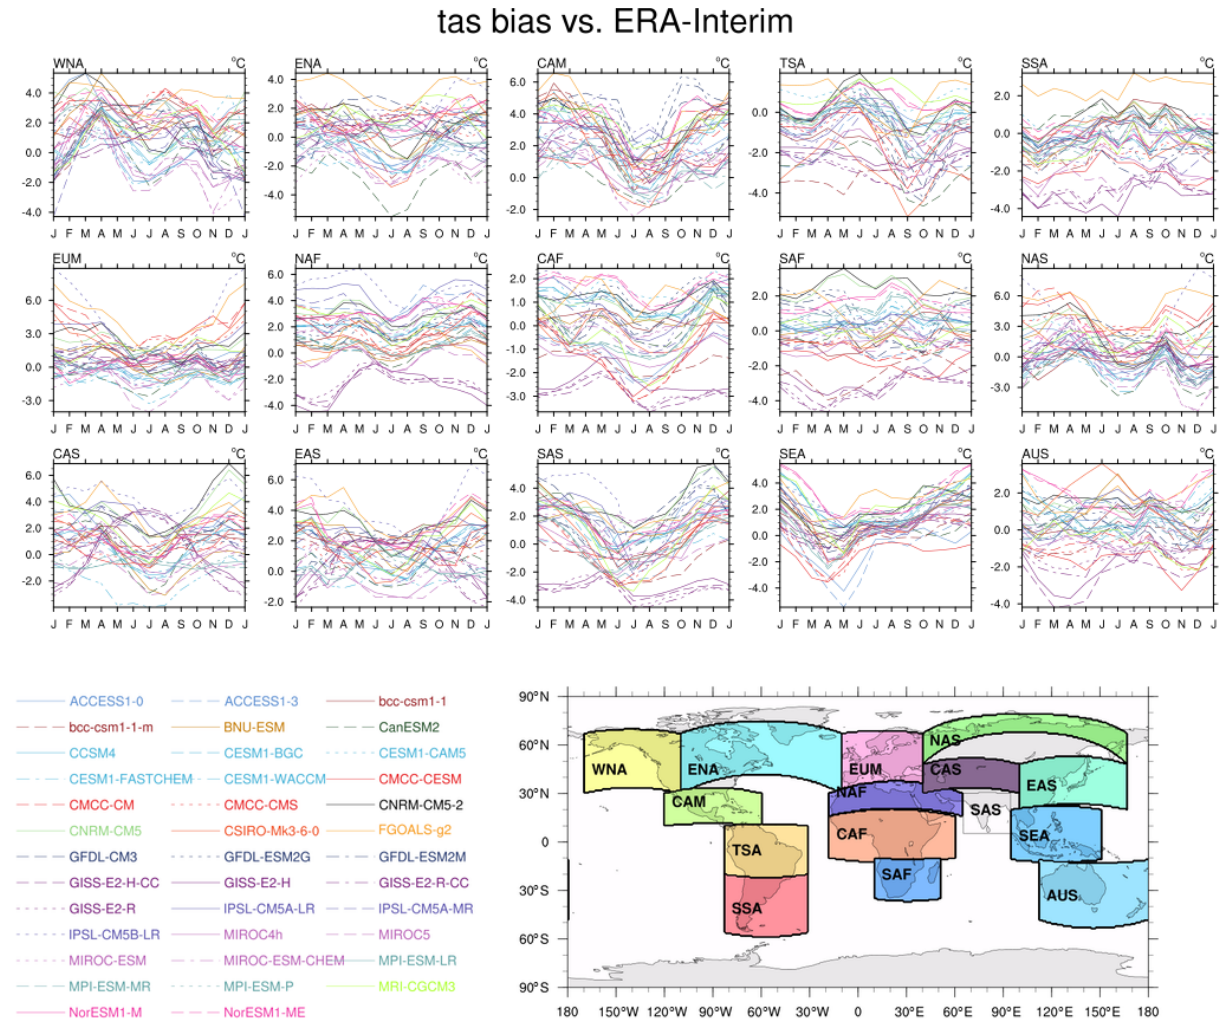
Figure 13. Difference of the mean seasonal cycle for the surface temperature (tas) between 38 CMIP5 models and ERA-Interim data averaged for 1980–1999 over land in different regions: western North America (WNA), eastern North America (ENA), Central America (CAM), tropical South America (TSA), southern South America (SSA), Europe and the Mediterranean (EUM), North Africa (NAF), central Africa (CAF), southern Africa (SAF), northern Asia (NAS), central Asia (CAS), East Asia (EAS), South Asia (SAS), Southeast Asia (SEA), and Australia (AUS). Similar to Fig. 9.38a of the IPCC AR5 report (Flato et al., 2013) and produced with recipe_flato13ipcc.yml ; for details see Sect.